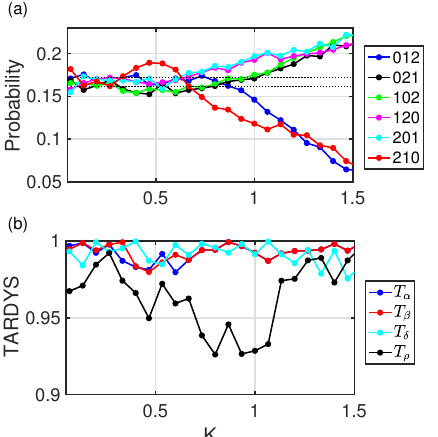
Figure A1. ( a ) Word probabilities of the circle map model as a function of K . ρ = − 0.23, α = 0.2, β = 0.2. ( b ) TARDYS quantifiers.